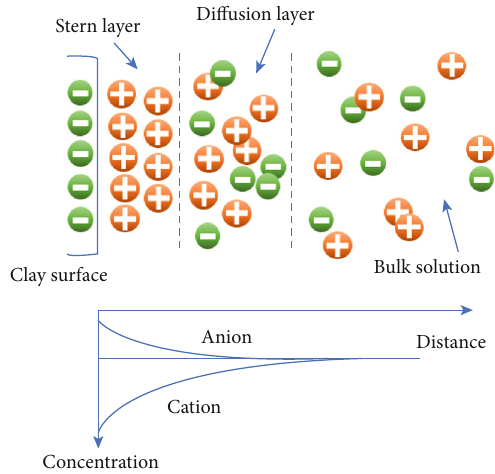
Figure 1: Stern electrical di ff usion double layer